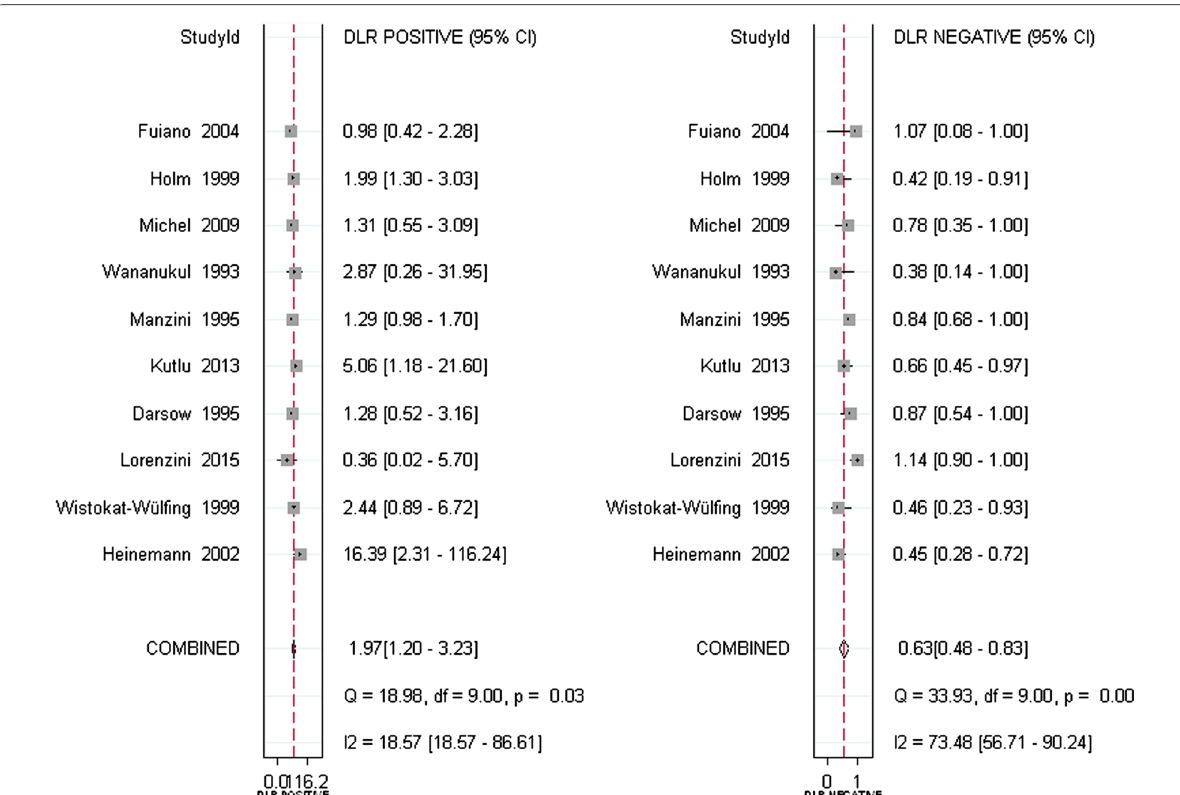
Fig. 5 The pooled PLR and NLR of APT in comparison to SPT for the diagnosis of patients with atopy dermatitis. CI confidence interval, ES